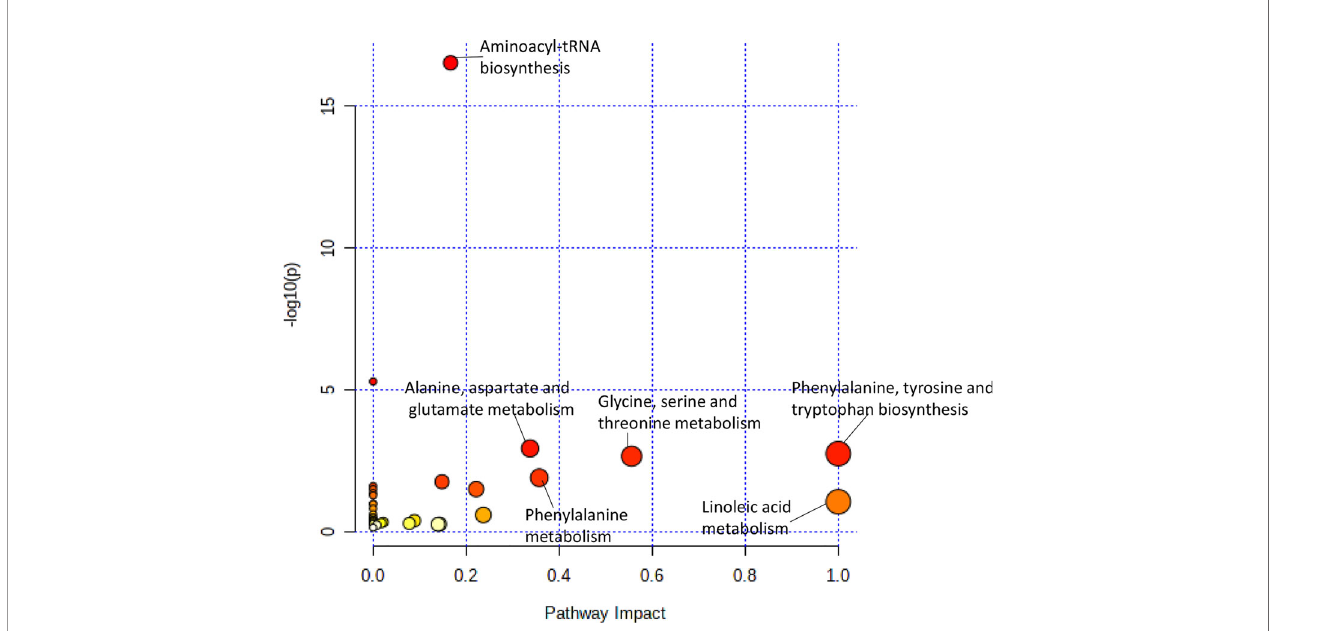
FIGURE 2 | Pathway analysis of metabolites signi fi cantly associated with doxorubicin AUC. Metabolic pathways associated with doxorubicin sensitivity showed a greater variety of amino acid synthesis and metabolism